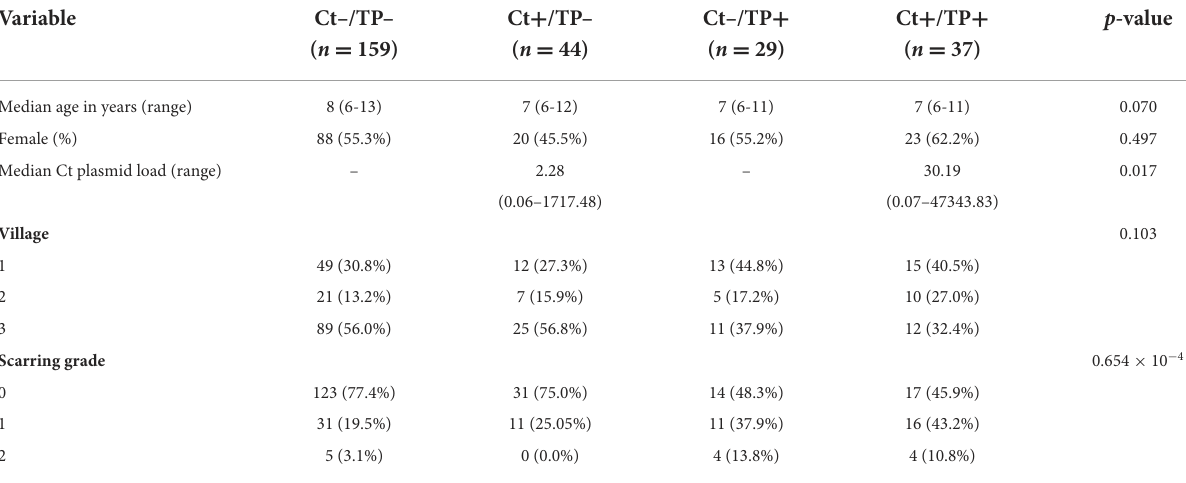
TABLE 1 Clinical information and demographics of the four study groups pre-MDA. Variable